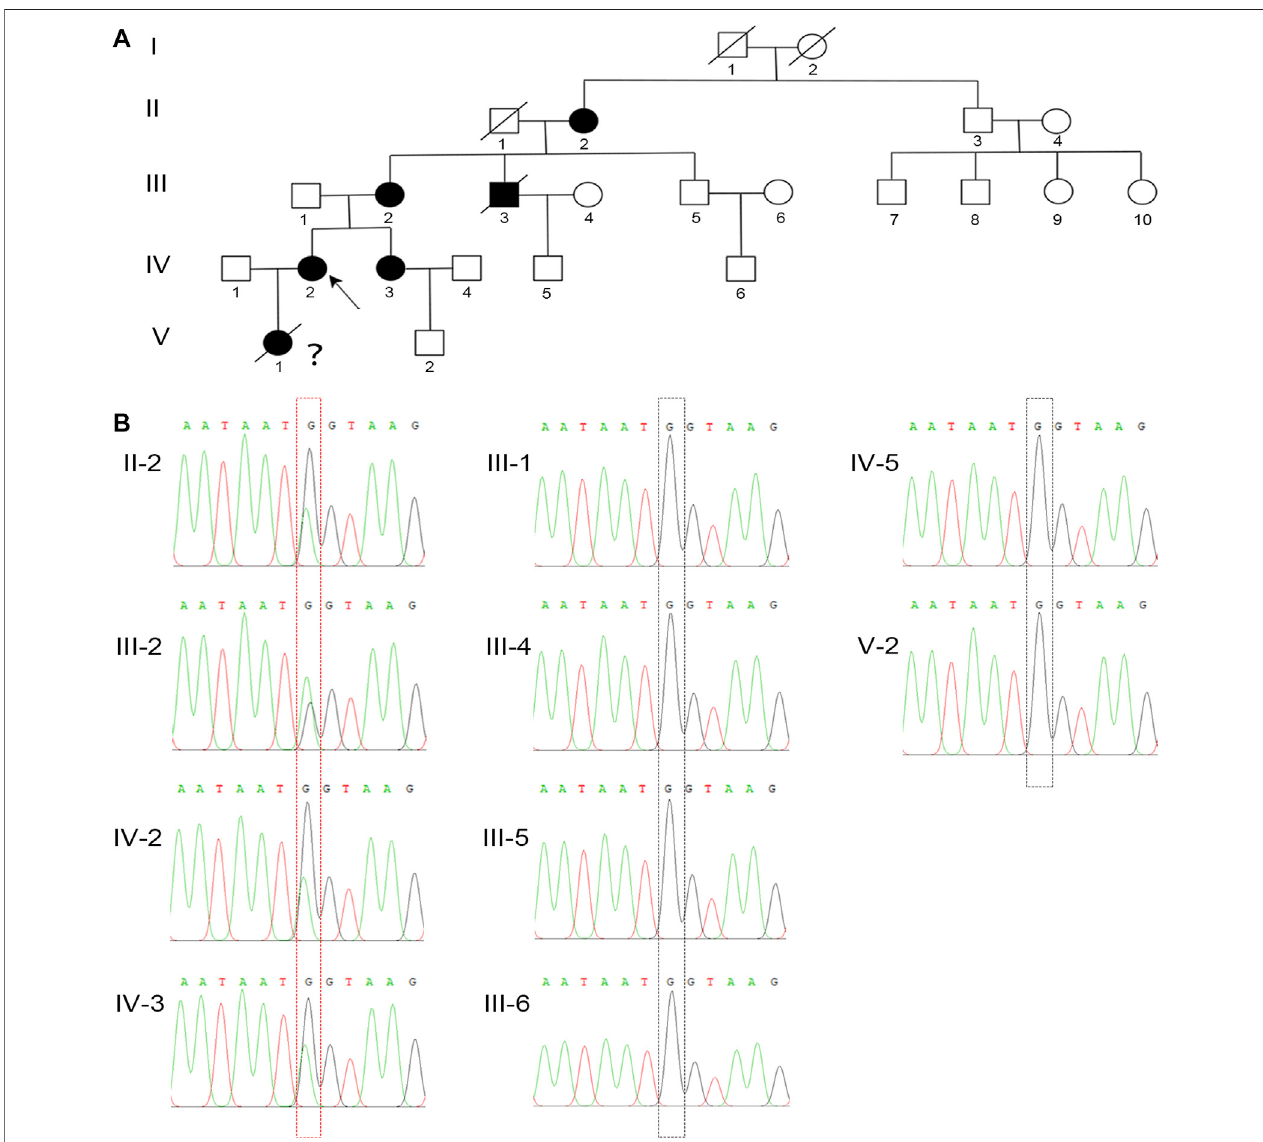
FIGURE 2 | A novel missense mutation in PHEX was detected in the XLH family. (A) The family pedigree of this XLH family. The black circles and square show the affectedindividualswithXLH,andtheprobandisindicatedbytheblackarrow.Becauseofthelackofclinicalandgeneticanalyses,thediagnosisandgenotypeofV-1are uncertain, which is indicated by a question mark. (B) Sanger sequencing con fi rmed a heterozygous G-to-A transversion at nucleotide c.1768 (red dotted box) of the PHEX gene in all XLH patients in this family, while the unaffected individuals were identi fi ed as wild type (black dotted box).